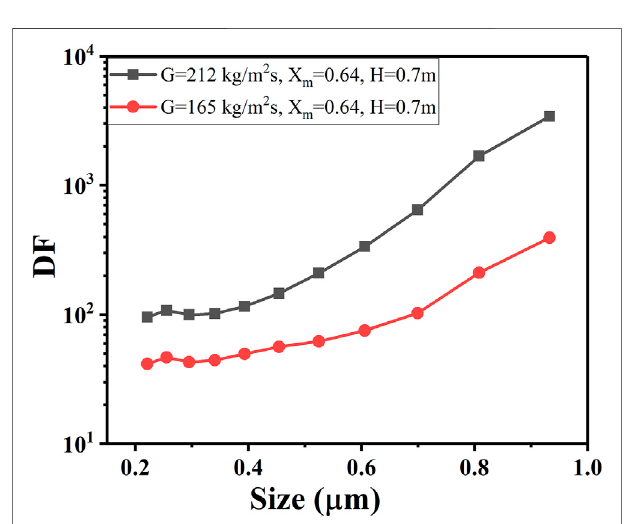
FIGURE 11 | In fl uence of mass fl ux on DF with the presence of steam under the jet regime.